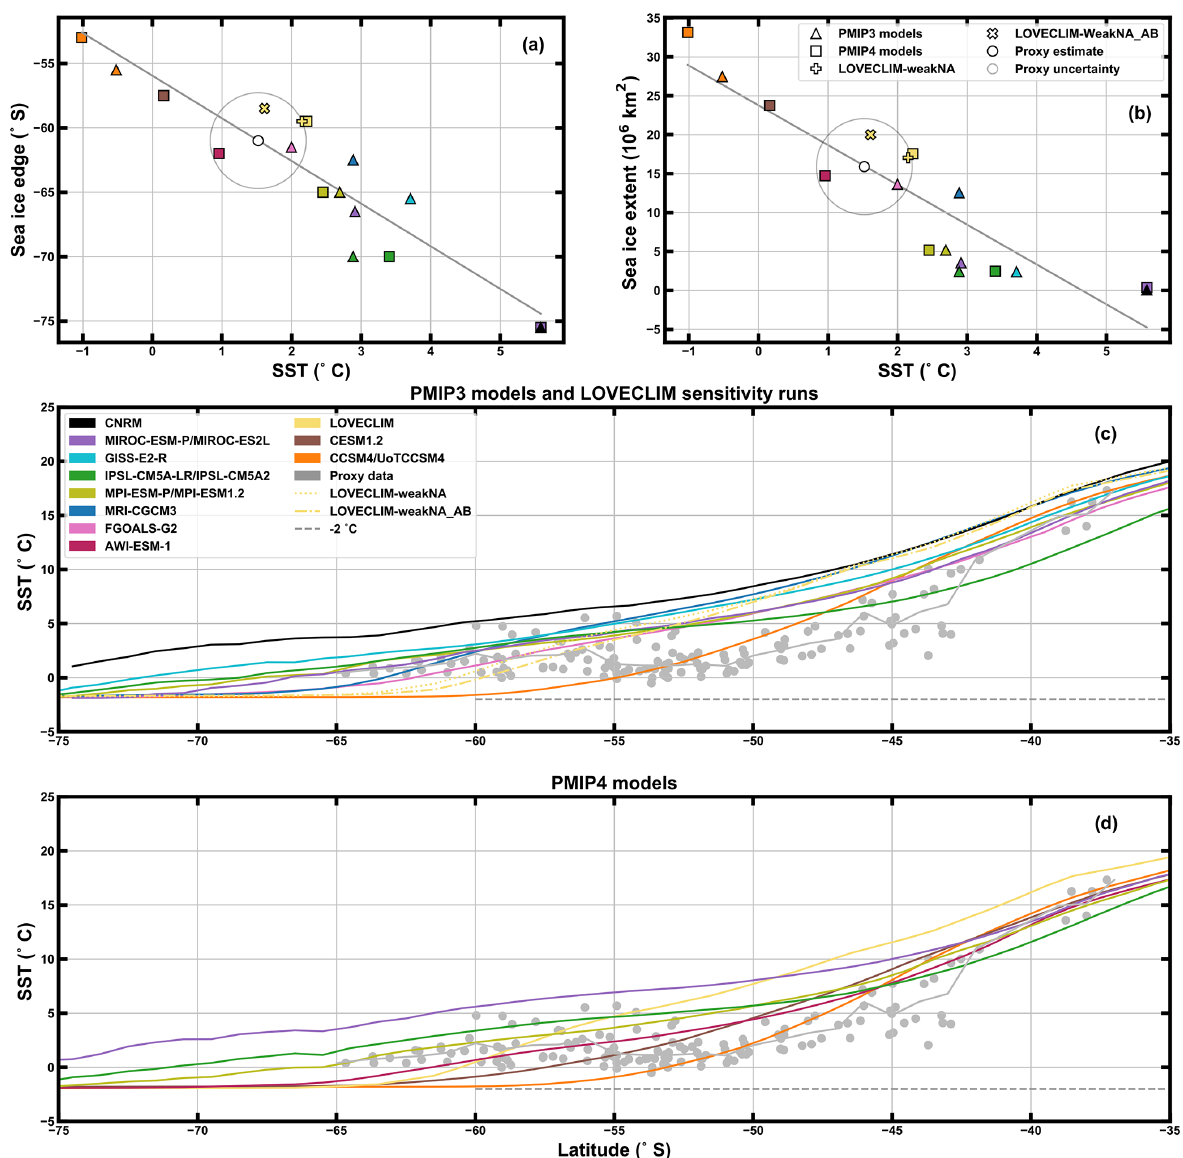
Figure 2. Austral summer sea-ice and SST. (a) Sea-ice edge vs. SST (50–75 ◦ S); (b) sea-ice extent vs. SST (50–75 ◦ S). Proxy summer sea-ice extent was estimated using the mean proxy SST value and the linear regression line. Uncertainty for the proxy SST value is shown in the gray circle. (c) Zonally averaged SST values in the SO as estimated from paleo-proxy records (gray points) and for PMIP3 models and the LOVECLIM sensitivity experiments. The gray line represents the fit through the proxy data. (d) Same as (c) for PMIP4